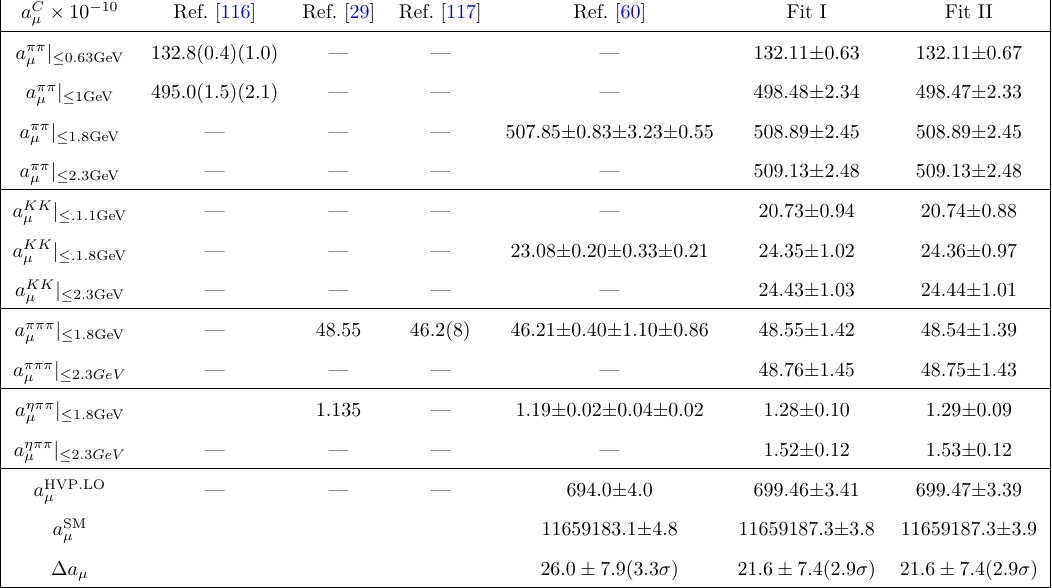
Table 3 . Our predictions of muon anomalous magnetic moment, where other contributions are from refs. [39, 60] and references therein. We compared the a C refs. [29, 60, 116, 117]. The experimental value is measured as a exp